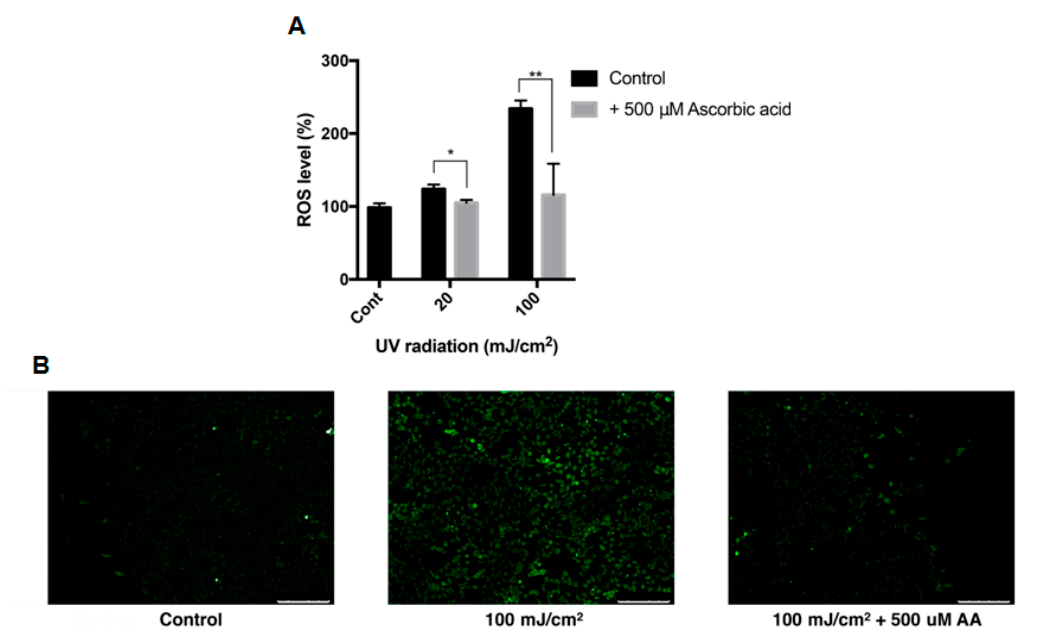
Figure 6. Intracellular ROS level of ARPE-19 after UVB treatment with ascorbic acid. The effects of ascorbic acid on the intracellular ROS level of ARPE-19 under UVB-induced oxidative stress were examined by DCFH-DA assay. Ascorbic acid at 500 µM significantly reduced the ROS level after UVB irradiation (20–100 mJ / cm 2 ) compared to groups with UVB irradiation only ( A ). The green fluorescence of the reacted DCFH-DA which indicates the ROS level, was observed with fluorescence microscopy (scale bar 250 µm) ( B ). Asterisks indicate a significant reduction in ROS level compared with control cells only with UVB exposure without ascorbic acid treatment (* p < 0.05, ** p < 0.01). ROS, reactive oxygen species; UVB, ultraviolet B; DCFH-DA, 2 ′ ,7 ′ -dichlorodihydrofluorescein diacetate; AA, ascorbic acid.